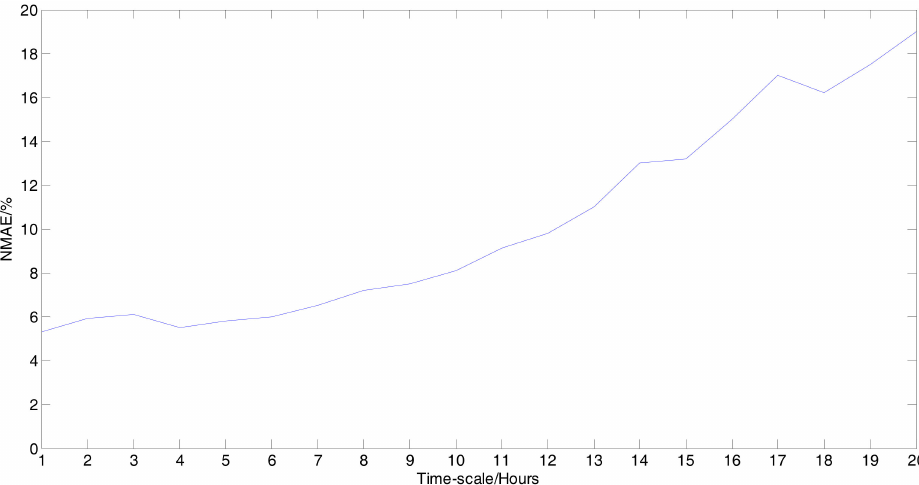
Figure 6. Relation between time-scale and